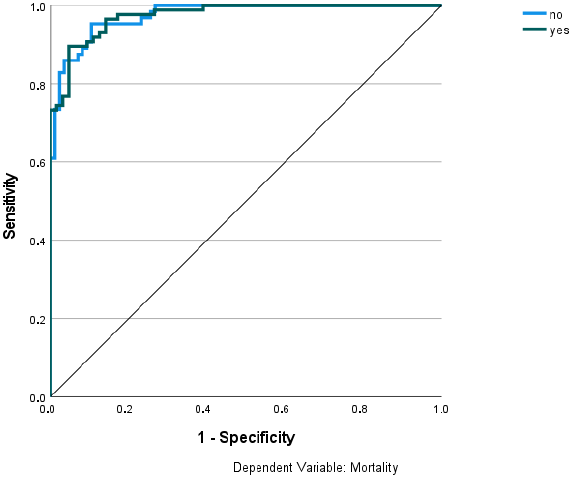
Figure 3. ROC curve based the predictions of multilayer perceptron multilayer model.